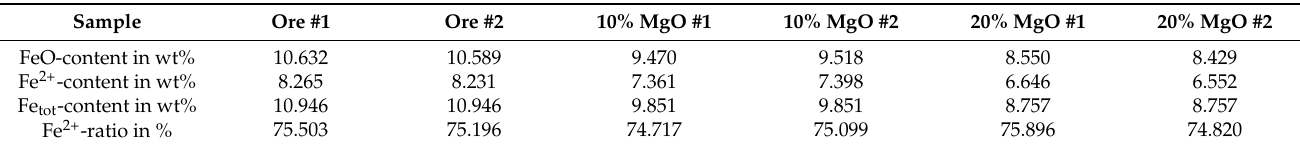
Table 6. Fe 2+ -content determined by thermogravimetric